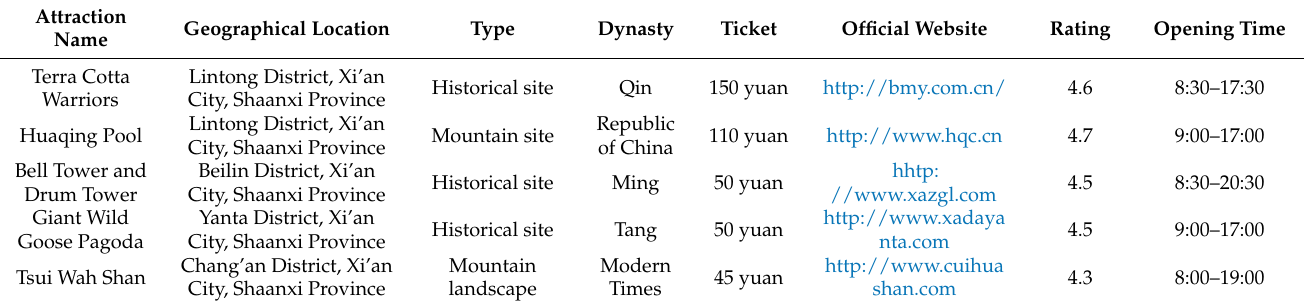
Table 1. Example of data